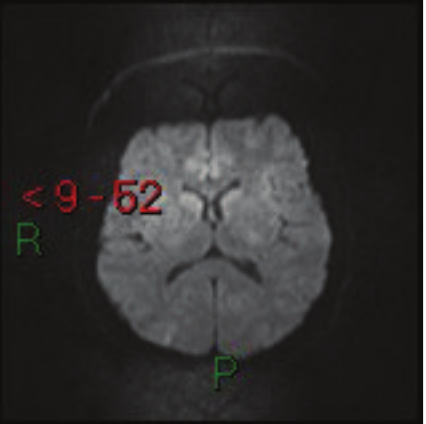
Figure 2: Case 1. Axial diffusion-weighted MRI: lesions do not present diffusion